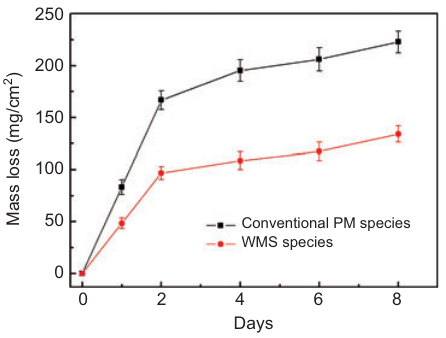
Figure 6 Mass loss of TiC/316L composites as a function of duration time in 15 wt. % H